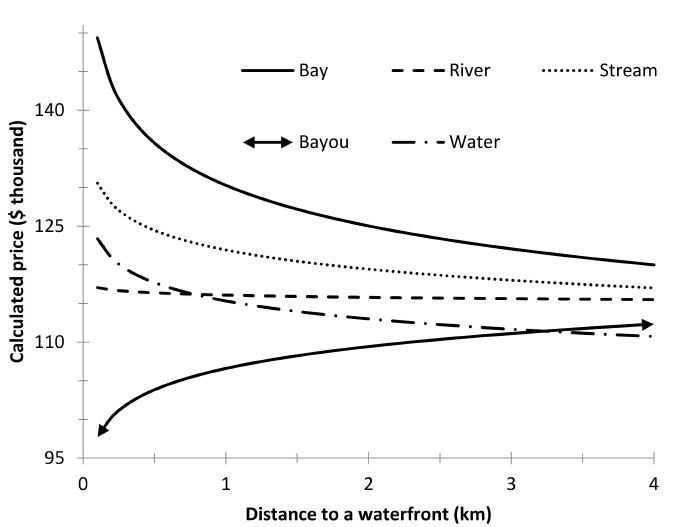
Figure 3. Relationships between assessed house value and proximity to waterfront ecosystem services.